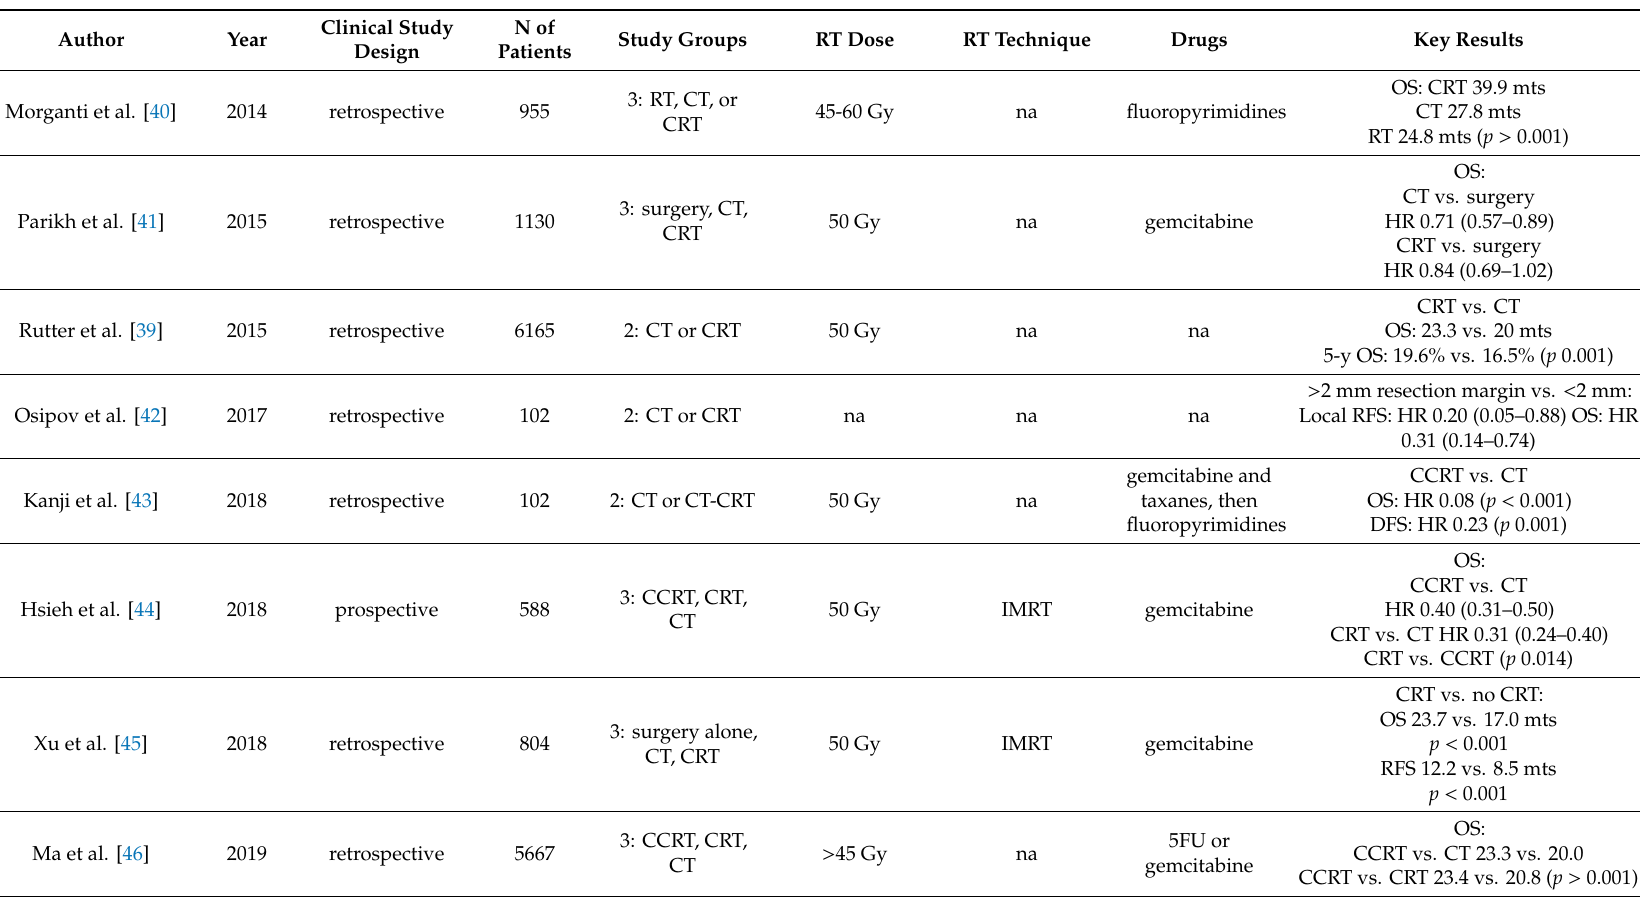
Table 3. Recent studies comparing clinical outcomes of adjuvant chemoradiation therapy vs. other strategies in resected pancreatic